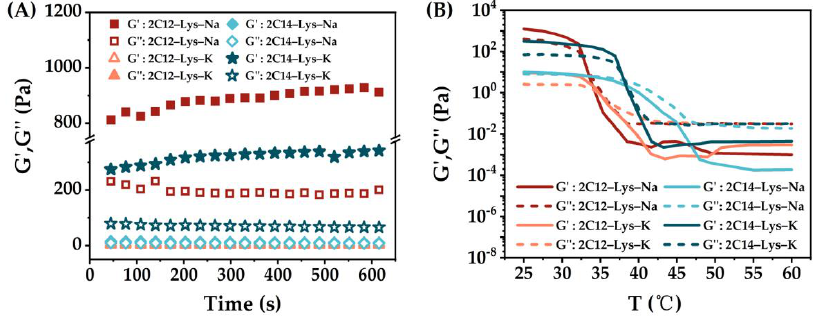
Figure 9. Rheological behaviors of gels formed by 2C12-Lys-Na, 2C12-Lys-K, 2C14-Lys-Na, and 2C14-Lys-K in isopropanol – water mixtures: ( A ) Variation of storage modulus (G’) and loss modulus (G ″ ) with time; ( B ) dependence of the storage modulus (G’) and loss modulus (G″ ) with the temperature.